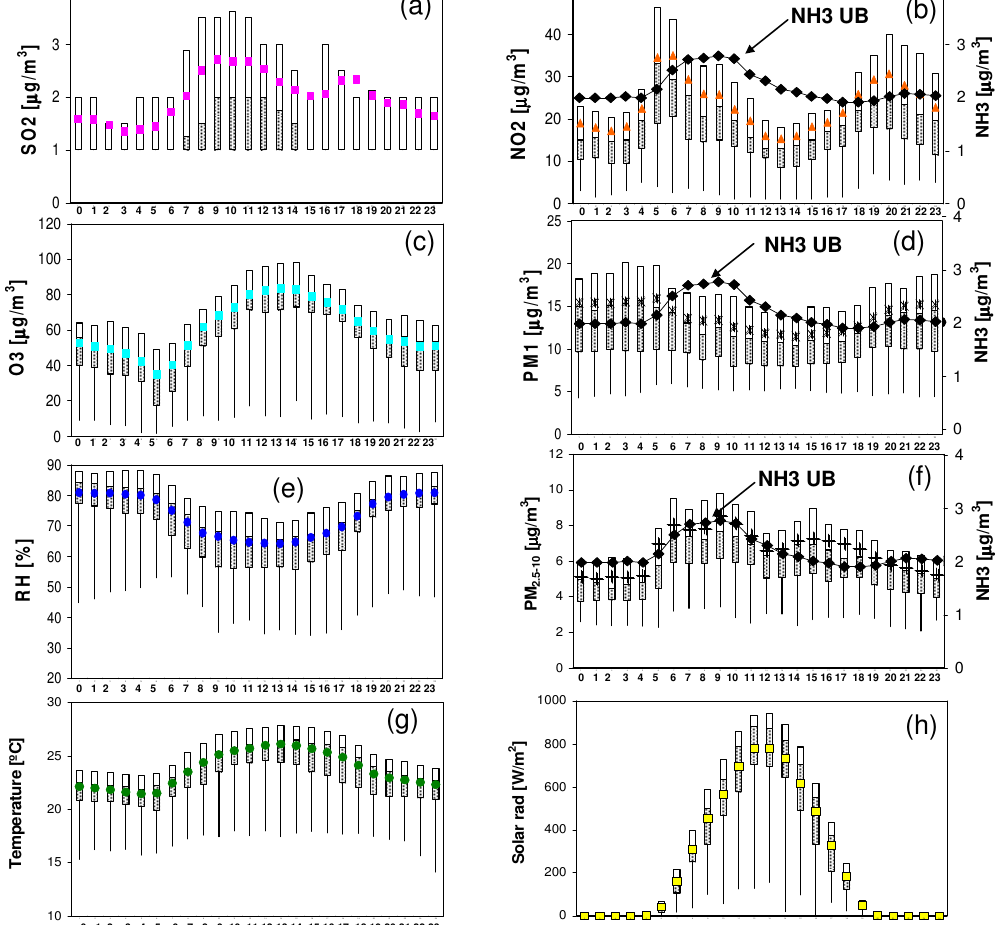
Fig. 6. Daily cycles of: (a) SO 2 concentrations, (b) NO 2 concentrations, (c) O 3 concentrations, (d) PM 1 concentrations, (e) relative humidity (RH), (f) PM 2 . 5 − 10 concentrations, (g) temperature, and (h) solar radiation measured at UB over the period 6 May–7 September. In (b, d, f) the diurnal cycle of NH 3 measured at UB over the 6 May–7 September period is also reported. Box-and whiskers plots represent the 25th and 50th percentiles (upper white and lower grey boxes), colored symbols represent the means, the black horizontal bands represent the median (50th percentiles) and lower error bars represent the minimum measured